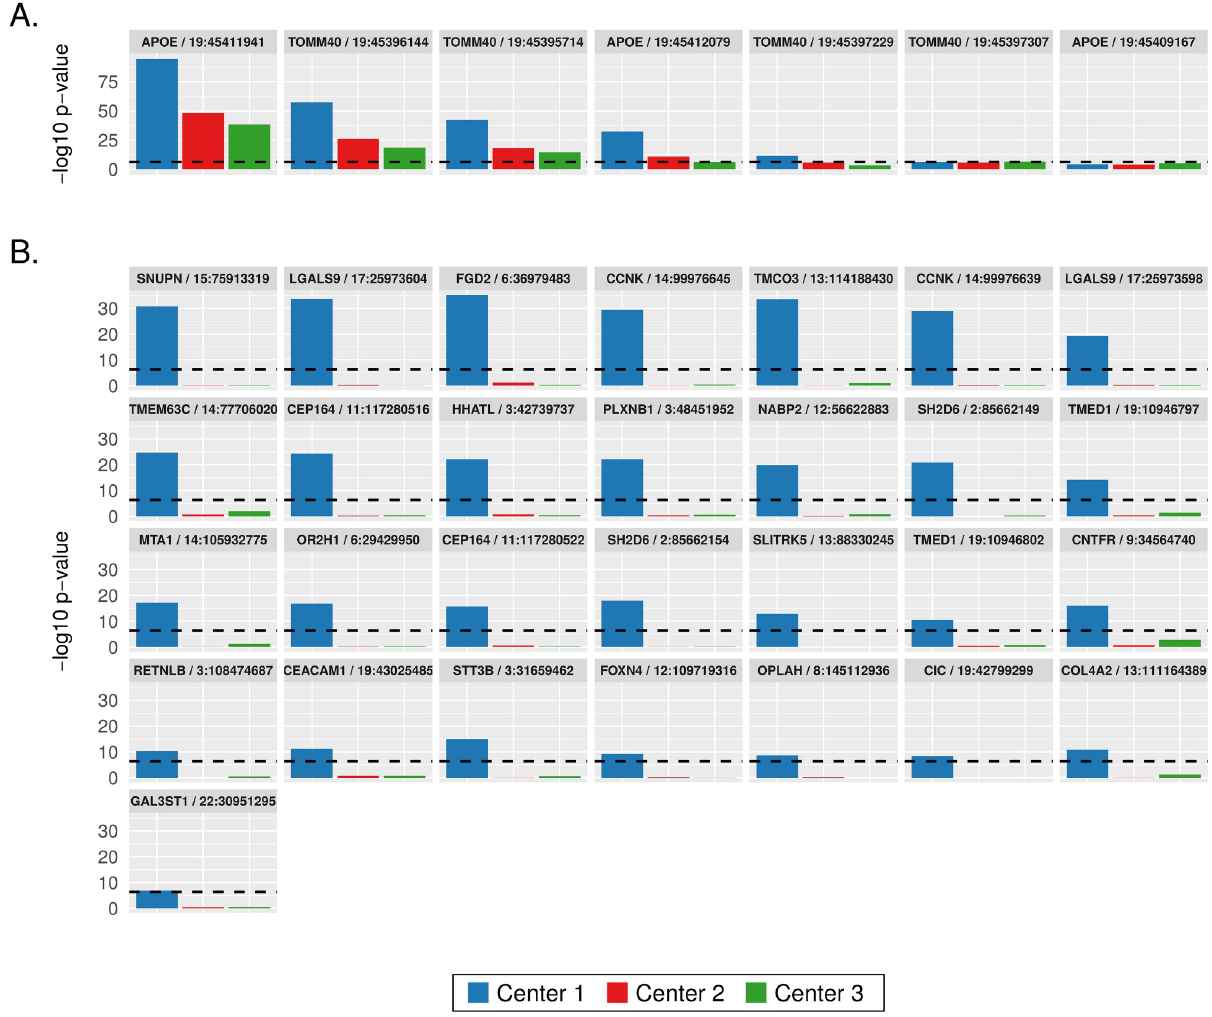
Fig 2. Sequencing center specific association p-values of SNPs that reached exome-wide significance (denoted by the dashed horizontal lines) in the full-dataset analysis. (A) Seven SNPs in TOMM40 and APOE . (B) Twenty-nine novel SNPs.